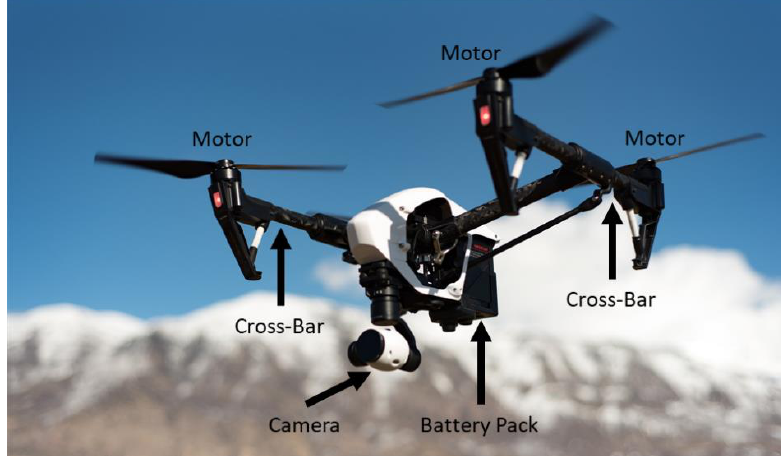
Figure 5. DJI Inspire 1 [48].